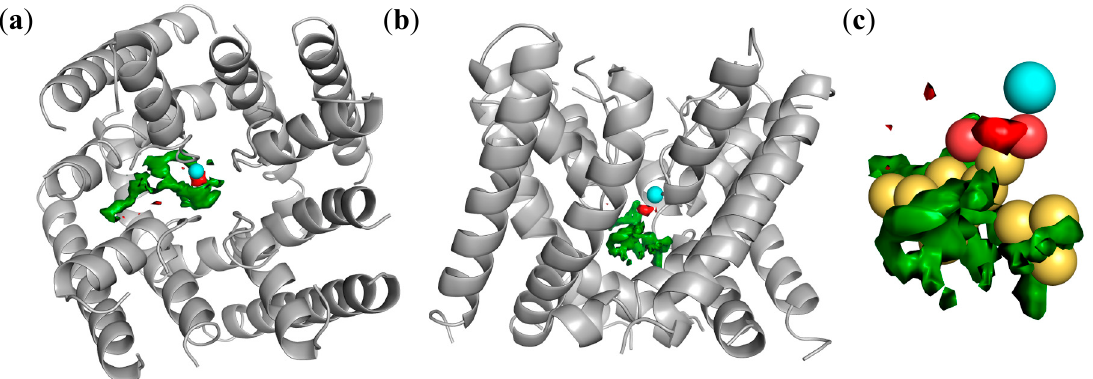
Figure 6. ( a , b ): Two views of the 3D-structure of LTCC (homology model by Tikonov and Zhorov [43]), in which one calcium ion is shown as a cyan sphere, whereas green and red surfaces represent GRID molecular interaction fields obtained within the pocket with the hydrophobic probe (DRY, field shown at − 2.0 kcal/mol) and the carbonyl oxygen probe (O, field shown at − 5.0 kcal/mol), respectively; ( c ) The pharmacophore, represented by yellow spheres (hydrophobic atoms) and red spheres (H-bonding accepting atoms), is reported docked within the LTCC